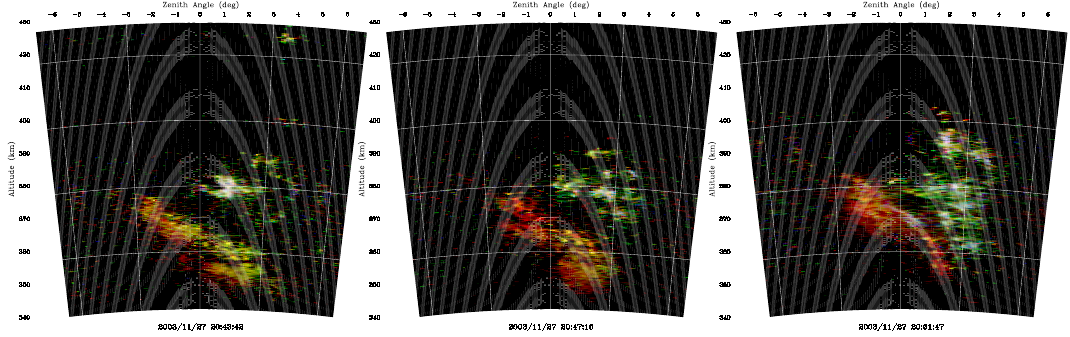
Fig. 5. Images of emerging radar plumes observed on 27 November 2003 at three local times. Pixel brightness represents the signal-to-noise ratio on a scale from 0–23dB.